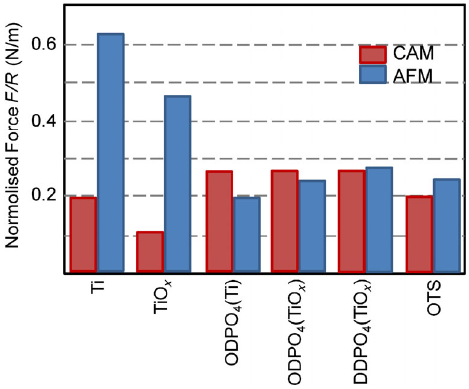
Fig. 7 Comparison of adhesion forces measured with AFM and